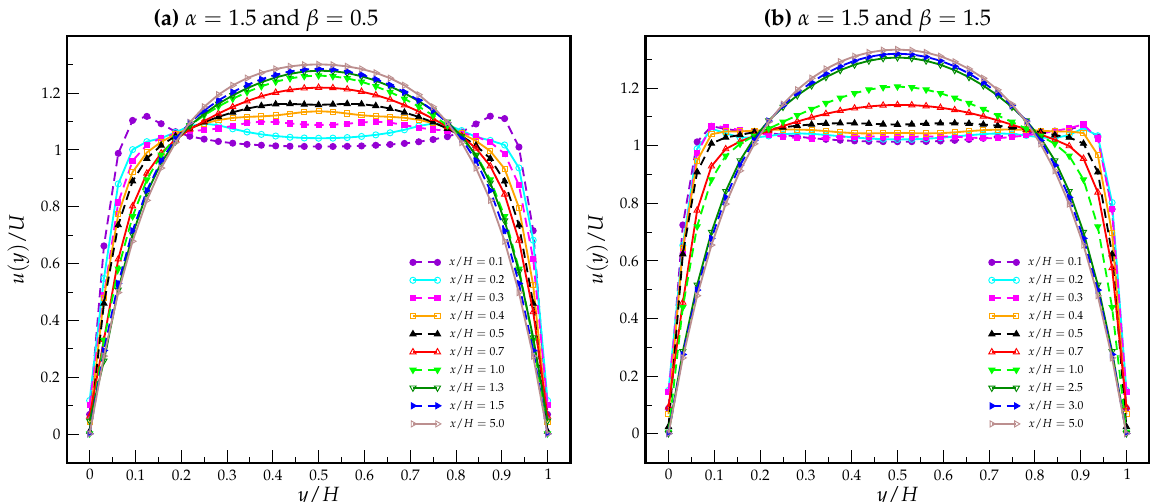
Figure 12. Velocity profiles obtained at 10 different sections of the channel for Wi = 1.0. (a) α = 1.5, β = 0.5; (b) α = 1.5, β = 1.5.